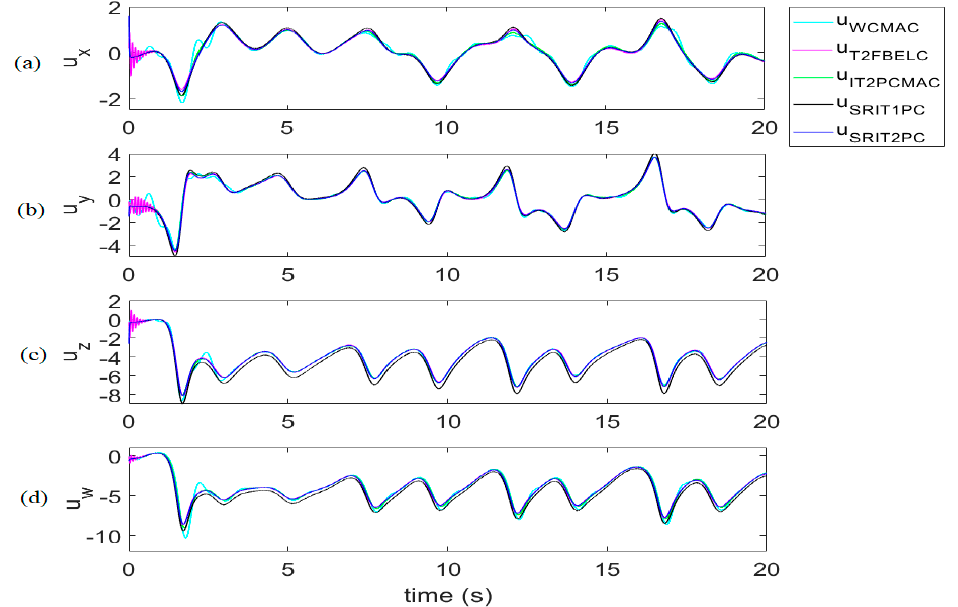
Figure 9. Control signals between the proposed SRIT2PC and other synchronization methods for Case